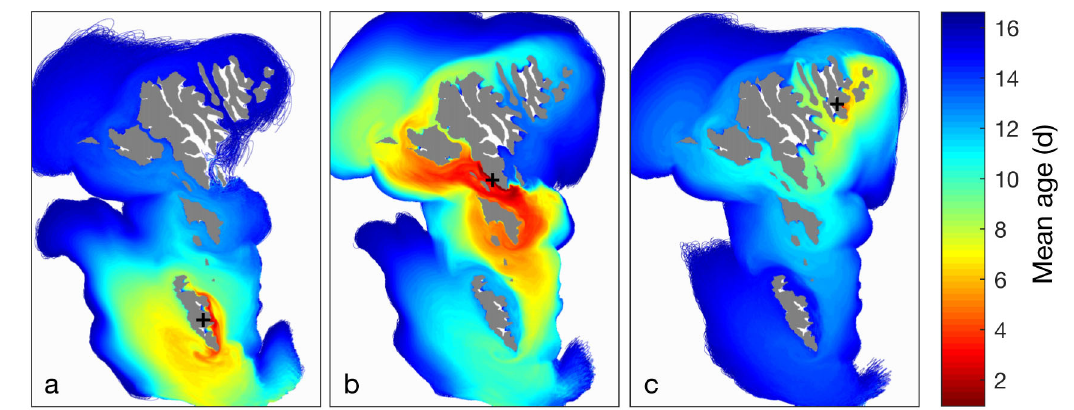
Fig. 4. Mean age of particles in every grid cell over the 2000 h simulation period. Every hour, 900 particles are released from Farms (a) 2, (b) 5, and (c) 21 (black crosses). White: no particles